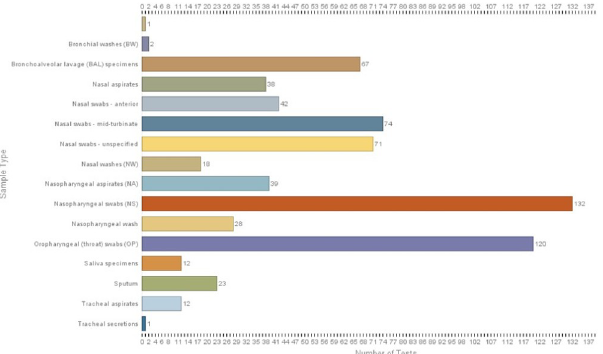
Fig 3. Example of a chart showing summary statistics for EUAdb, in this case the number of tests using a particular sample type. In the upper right corner is a query field for showing all tests that use a selected sample type. Such charts can also be generated for RNA extraction kits, PCR master mixes, primer sets, target genes, instrumentation, and limits of